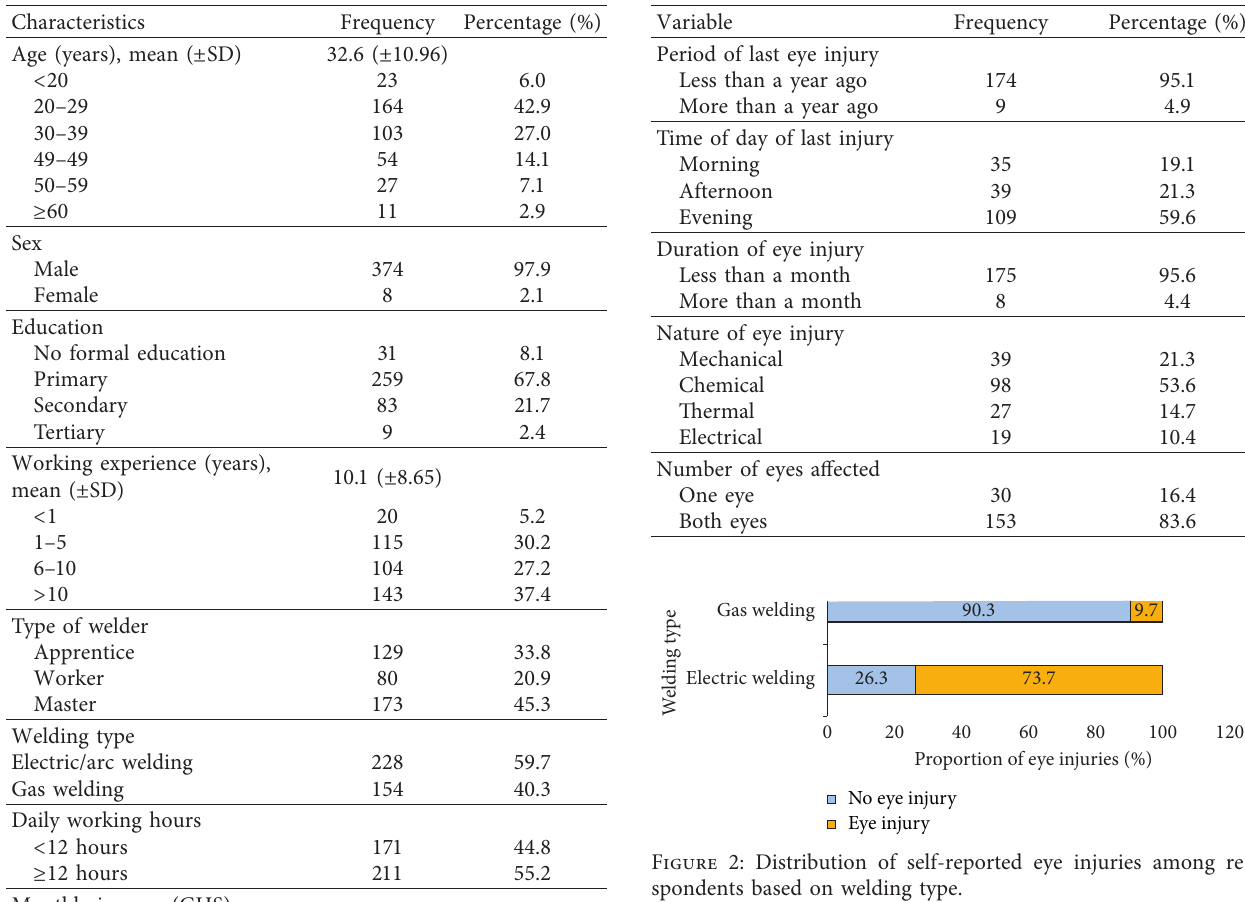
Table 2: Characteristics of eye injuries among welders ( N � 183).